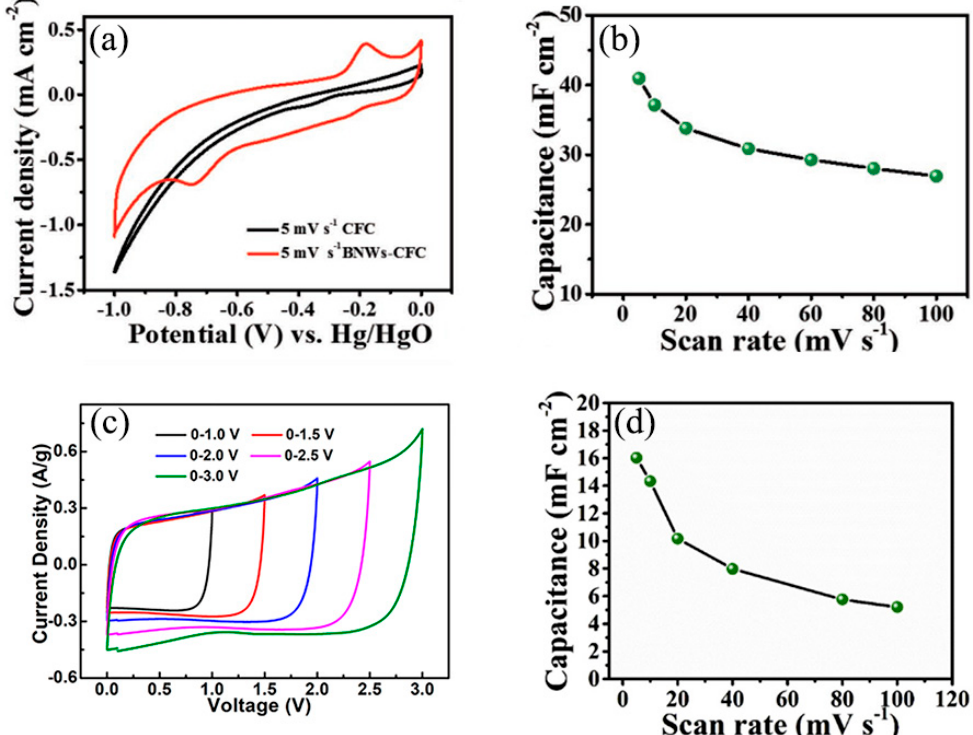
Figure 12. ( a ) Comparison of CV curves of carbon fiber cloth (CFC) and boron nanowire–carbon fiber cloth (BNWs–CFC) at a scan rate of 5 mV s − 1 . ( b ) Areal capacitances of BNWs–CFC at different scan rates [73]. Copyright 2018, Wiley. ( c ) CV curves collected under various voltage windows at a scan rate of 10 mV s − 1 of B sheets [62]. Copyright 2018, American Chemical Society. ( d ) Plots of scan rates